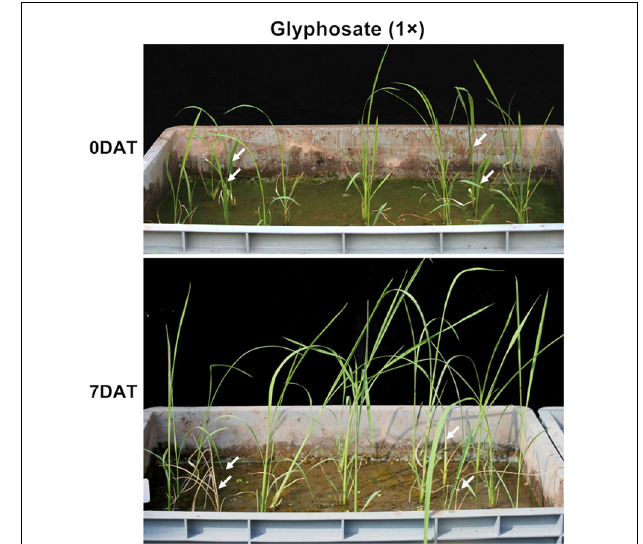
FIGURE 3 | The glyphosate-resistance level test of the pCEiEPSPS T 0 transgenic plants. Fifteen pCEiEPSPS T 0 transgenic plantlets and four WT plantlets (white arrows) were planted into the soil per pot. The phenotypes were recorded before [0 days after treatment (DAT)] and 7 (7DAT) days after spraying 0.1125 g a.e./m 2 (1 × ) glyphosate. No WT plantlet survived from glyphosate while most of the pCEiEPSPS T 0 transgenic plantlets grew